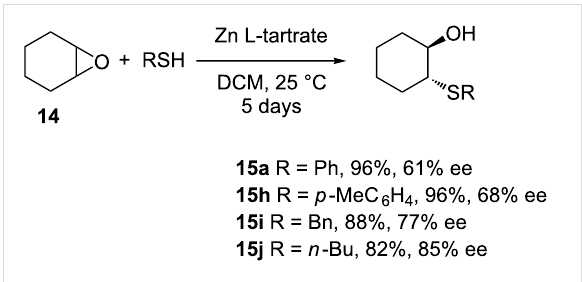
Scheme 11: Asymmetric ring-opening of cyclohexene oxide with various thiols catalyzed by zinc L-tartrate.